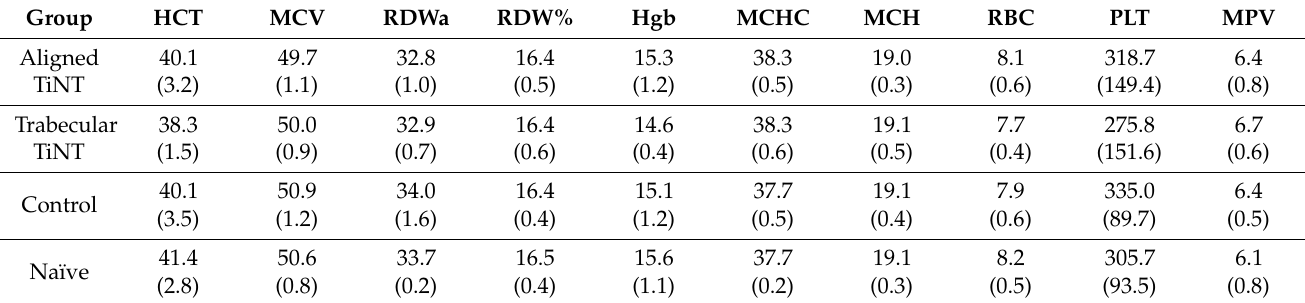
Table 2. Hematologic analysis of red blood cell function of each treatment group at endpoint.*